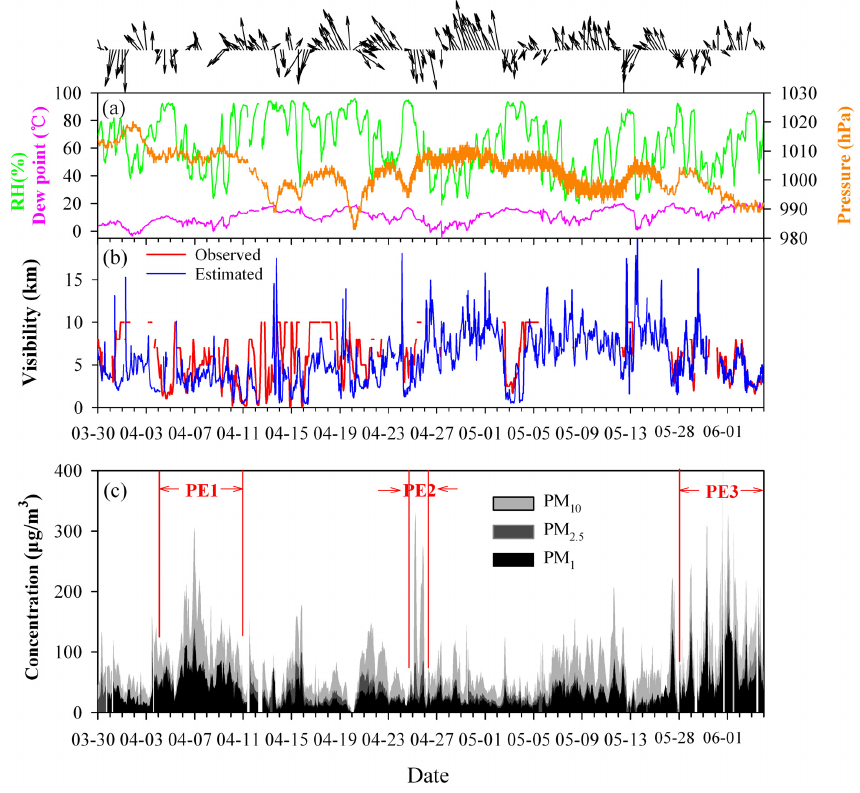
Fig. 1. (a) Time-series of the meteorological parameters during the study period (30 March ~ 16 May and 28 May ~ 3 June) in 2009 over Shanghai, including wind speed (ms -1 ), wind direction, relatively humidity (%), dew point ( ℃ ) and atmospheric pressure (hPa) (b) Time-series of the calculated and observed hourly visibility (km) during the same study period as above. The observed visibility recorded at Pudong had an upper limit of 10km (Data source: National Climatic Data Center (NCDC)). The method of calculating the visibility was described in Appendix A. (c) Time-series of the hourly particulate concentrations of PM 1 , PM 2.5 and PM 10 ( μ gm -3 ), three pollution episodes were highlighted in the figure.